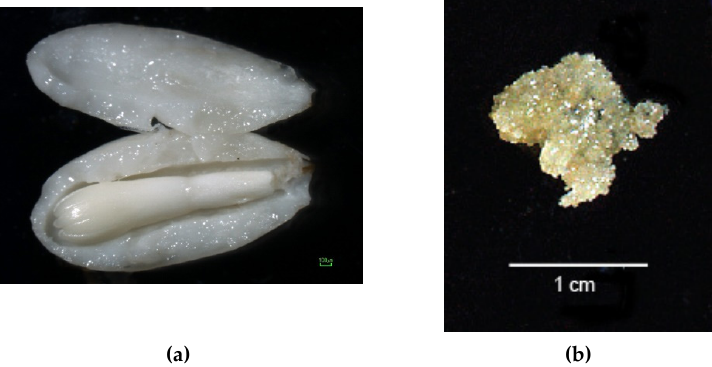
Figure 1. ( a ) Developmental stage of the megagametophyte used to initiate maritime pine